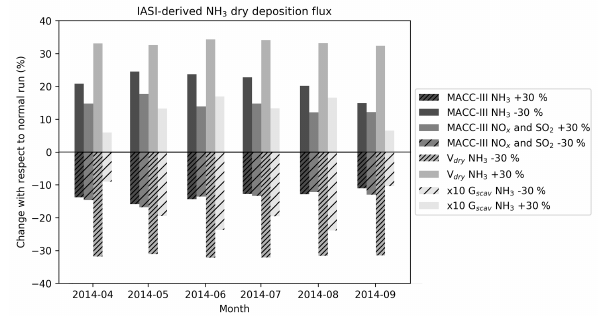
Figure 17. The change (%) in the monthly mean IASI-derived NH 3 dry deposition flux resulting from different perturbations of the LOTOS-EUROS